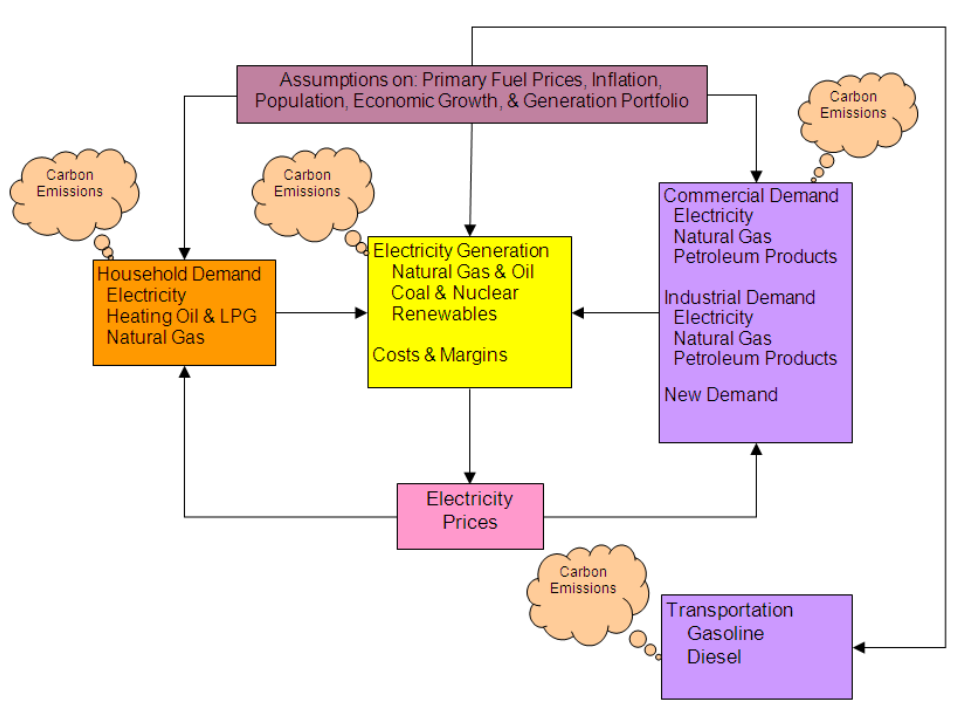
Figure 1. Energy model